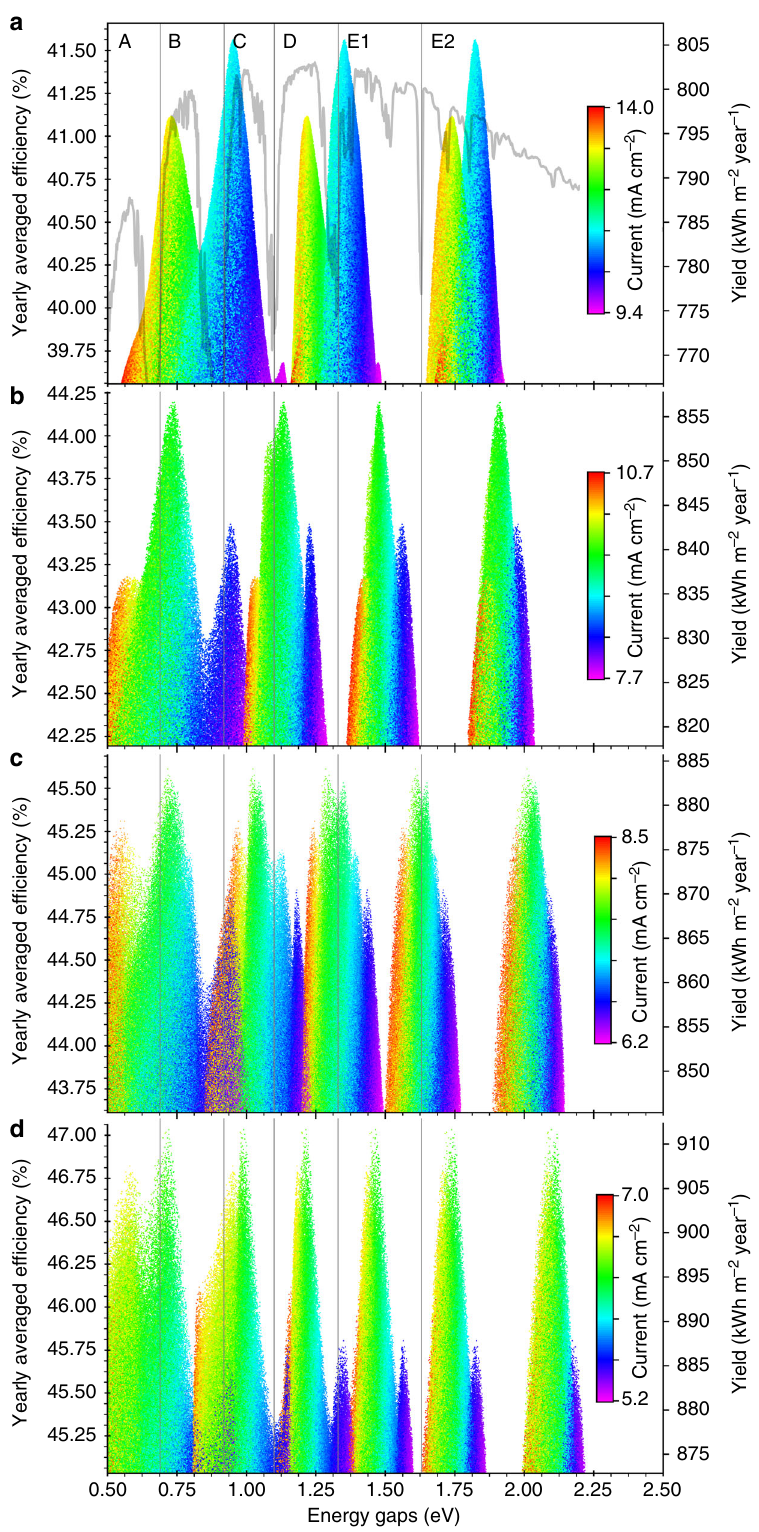
Fig. 5 Energy yields at 1000 suns. a Three junctions. The standard direct spectral irradiance is overlaid to highlight the alignment of the optimal band gaps with the transmission bands in the spectrum. b Four junctions. c Five junctions. d Six